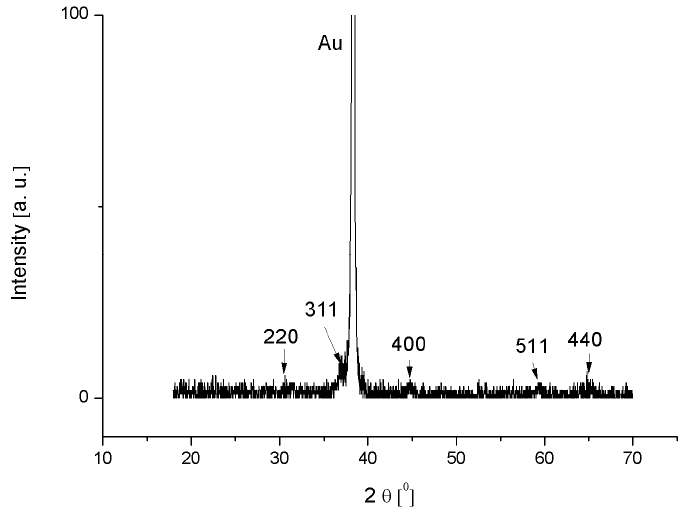
Figure 2. The XRD spectrum of C 3 O 4 nanostructures on an Au-coated glass